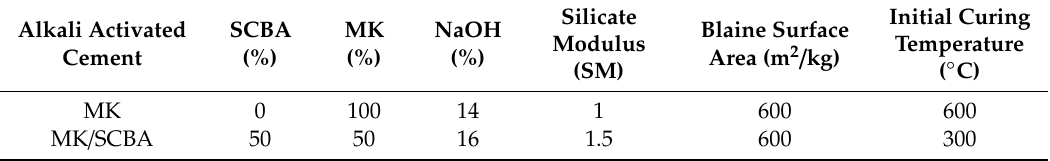
Table 2. Formulation of activated cements.